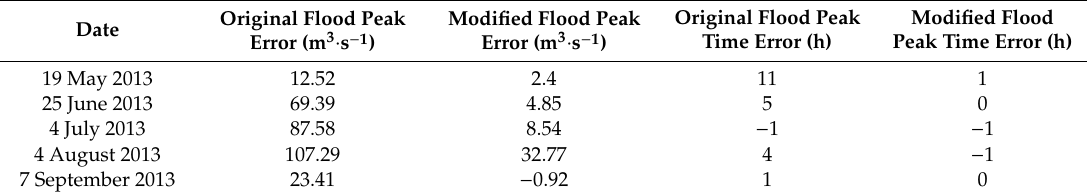
Table 4. Simulation results of flood peak before and after model modification during the calibration period.